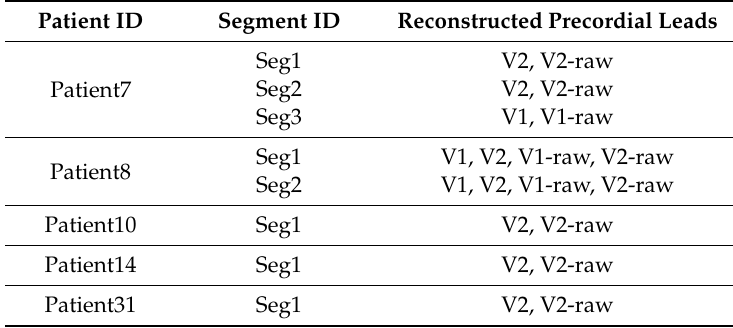
Table 3. List of patients with reconstructed precordial